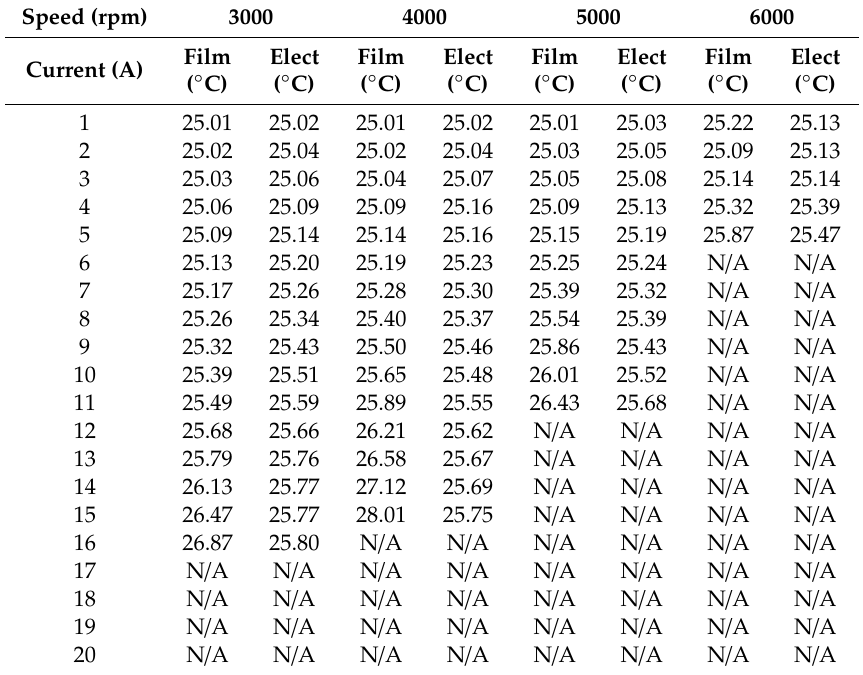
Figure 25. Heat generation by the electrolytic and film capacitor as functions of the motor speed. Table 9. Heat generation by the electrolytic and film capacitor at a speed range of 3000–6000